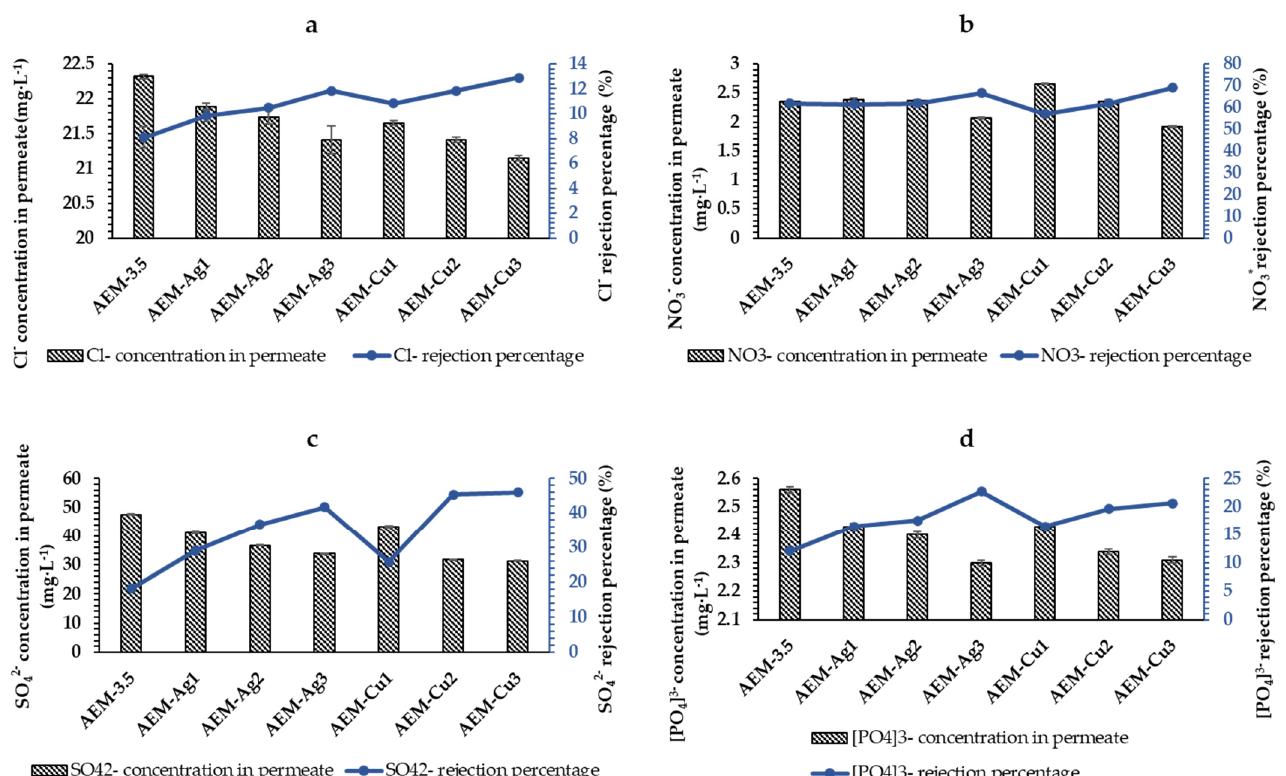
Figure 8. Anion rejection percentage of pristine AEM-3.5, Ag- and Cu-functionalized AEM-3.5 at 0.5 bars in a dead-end filtration system, and concentration value of anion in permeate: ( a ) Cl - , ( b ) NO 3 - , ( c ) SO 42 − , and ( d ) PO 43 − .